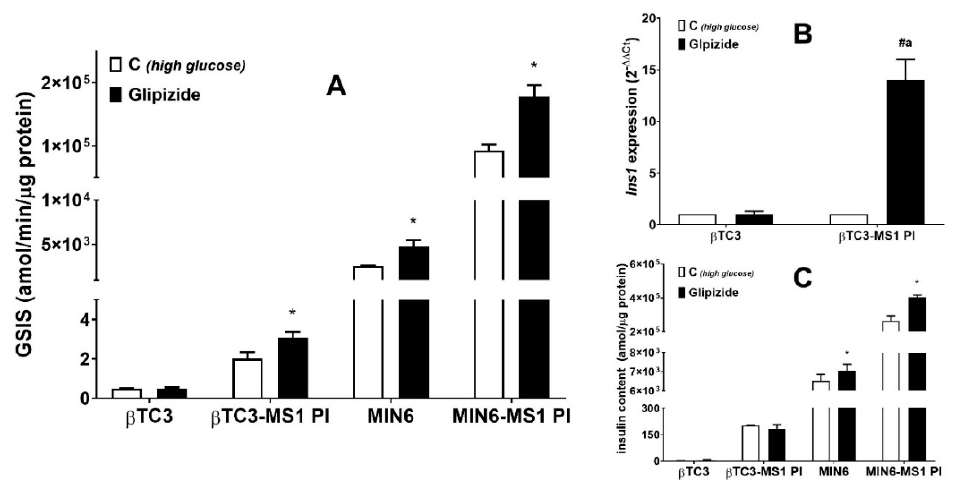
Figure 3. Responsiveness of β TC3 and MIN6 cell lines while maintained in the form of adherent monocultures ( β TC3 and MIN6, respectively) or three-dimensional (3D) pseudoislets (PI) in co-cultures with MS1 cells ( β TC3-MS1 PI and MIN6-MS1 PI, respectively) to Glipizide. ( A ) GSIS in adherent cells or PIs treated with Glipizide. ( B ) Expression of Ins1 in β TC3 and β TC3-MS1 PI after treatment with Glipizide. ( C ) Insulin content in adherent cultures and MS1-supplemented PIs of β TC3 and MIN6 treated with Glipizide. For the p -value less than 0.05 results are regarded as significantly di ff erent from the corresponding control (high glucose) conditions ( C ) * or from adherent cultures treated with Glipizide a .